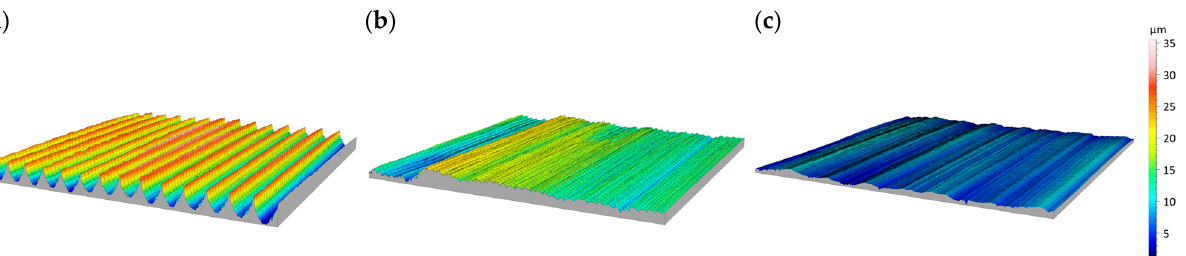
Figure 12. Microscopic view of the machined surface: ( a ) view of the surface in its initial state after shape milling at 400 × magnification; ( b ) view of the surface after shape milling and rough grinding at 400 × magnification; ( c ) view of the surface after shape milling, rough grinding and finish grinding at 400 × magnification.